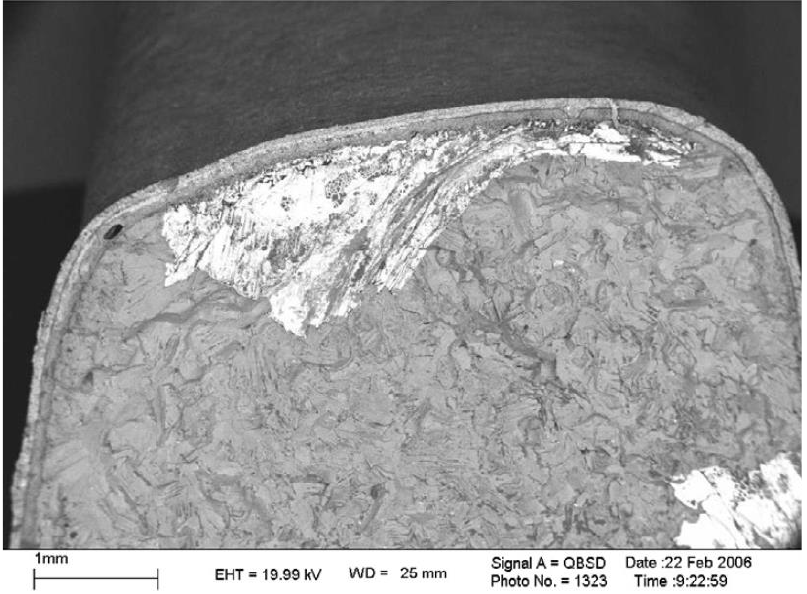
Figure 10. An oxide film exposed on the fracture surface of a WE43 magnesium alloy casting Reprinted with permission from ref. [52]. Copyright 2022 Elsevier.